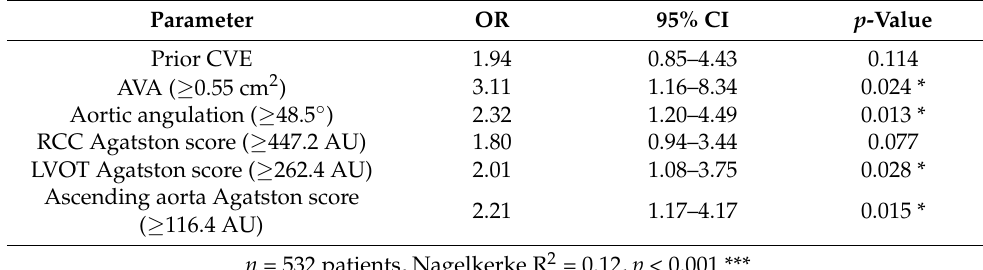
Table 3. Risk model I (pre-procedural parameters). Parameter